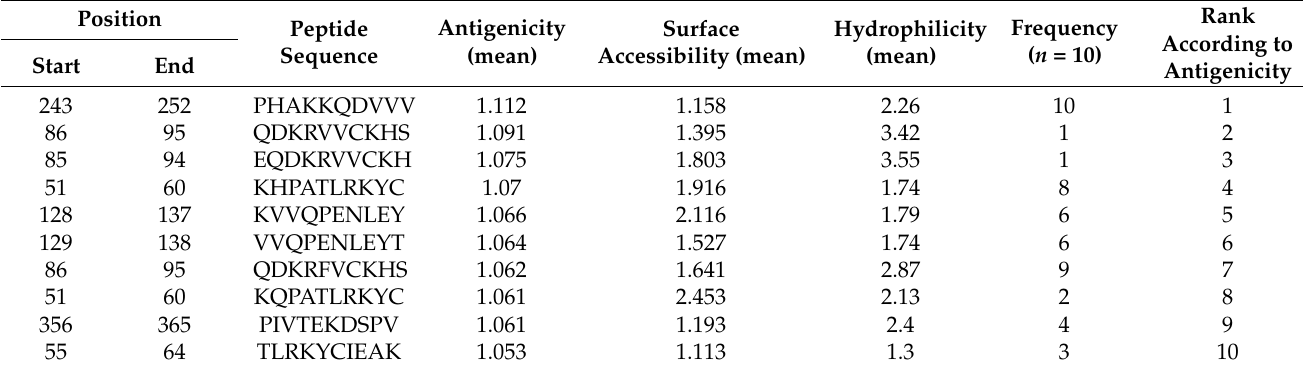
Table 2. Antigenicity, surface accessibility, hydrophilicity, and frequencies of top epitopes of DENV-2 E